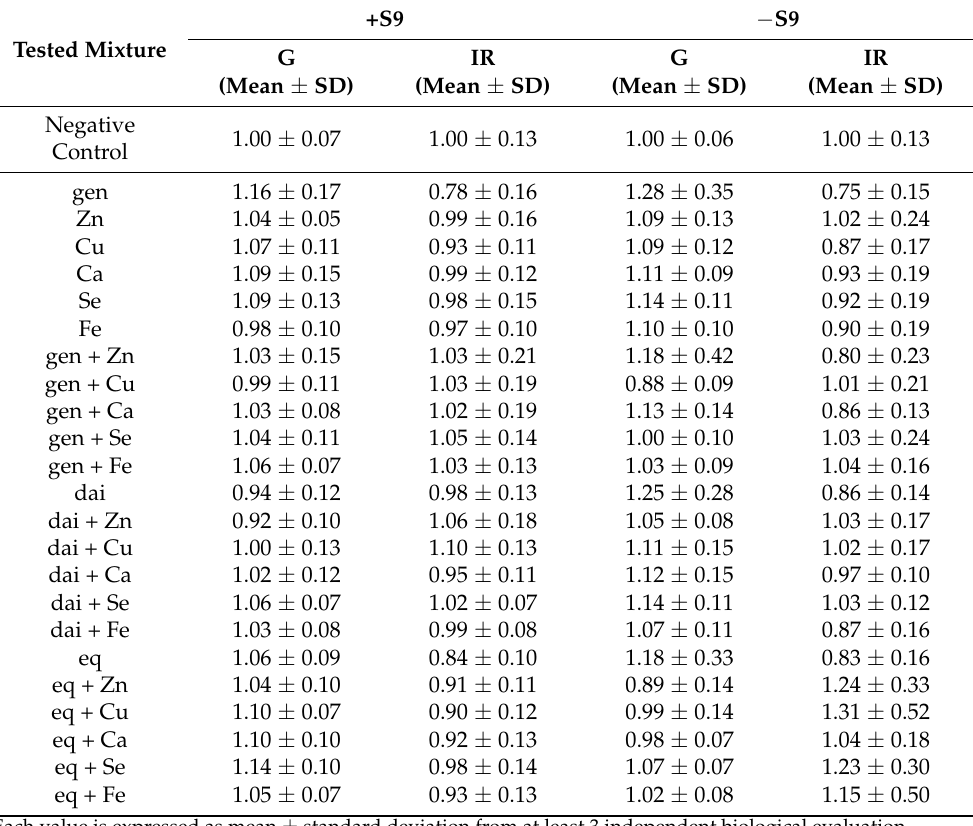
Table 1. Genotoxicity assessment—the values of growth (G) and induction (IR) ratios for the tested compounds and their combinations with (+S9) and without metabolic activation ( − S9).